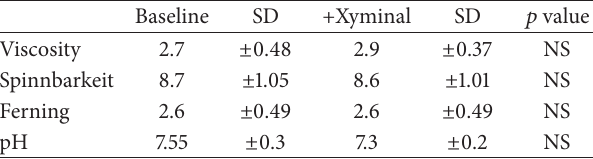
Table 4: Postcoital test results on cervical